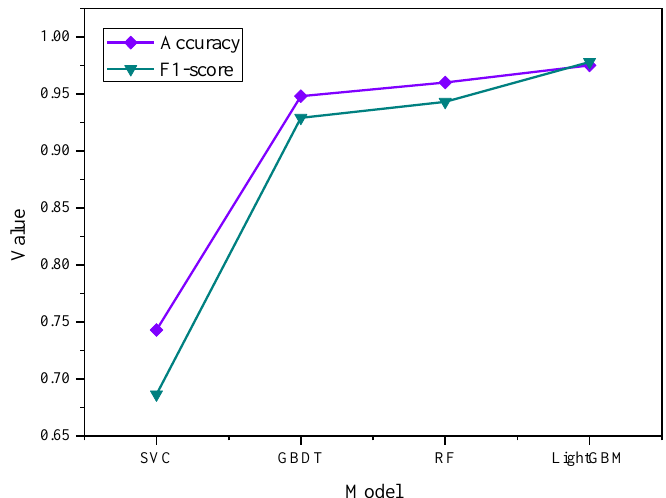
Figure 15. Performance indicators of four prediction models.